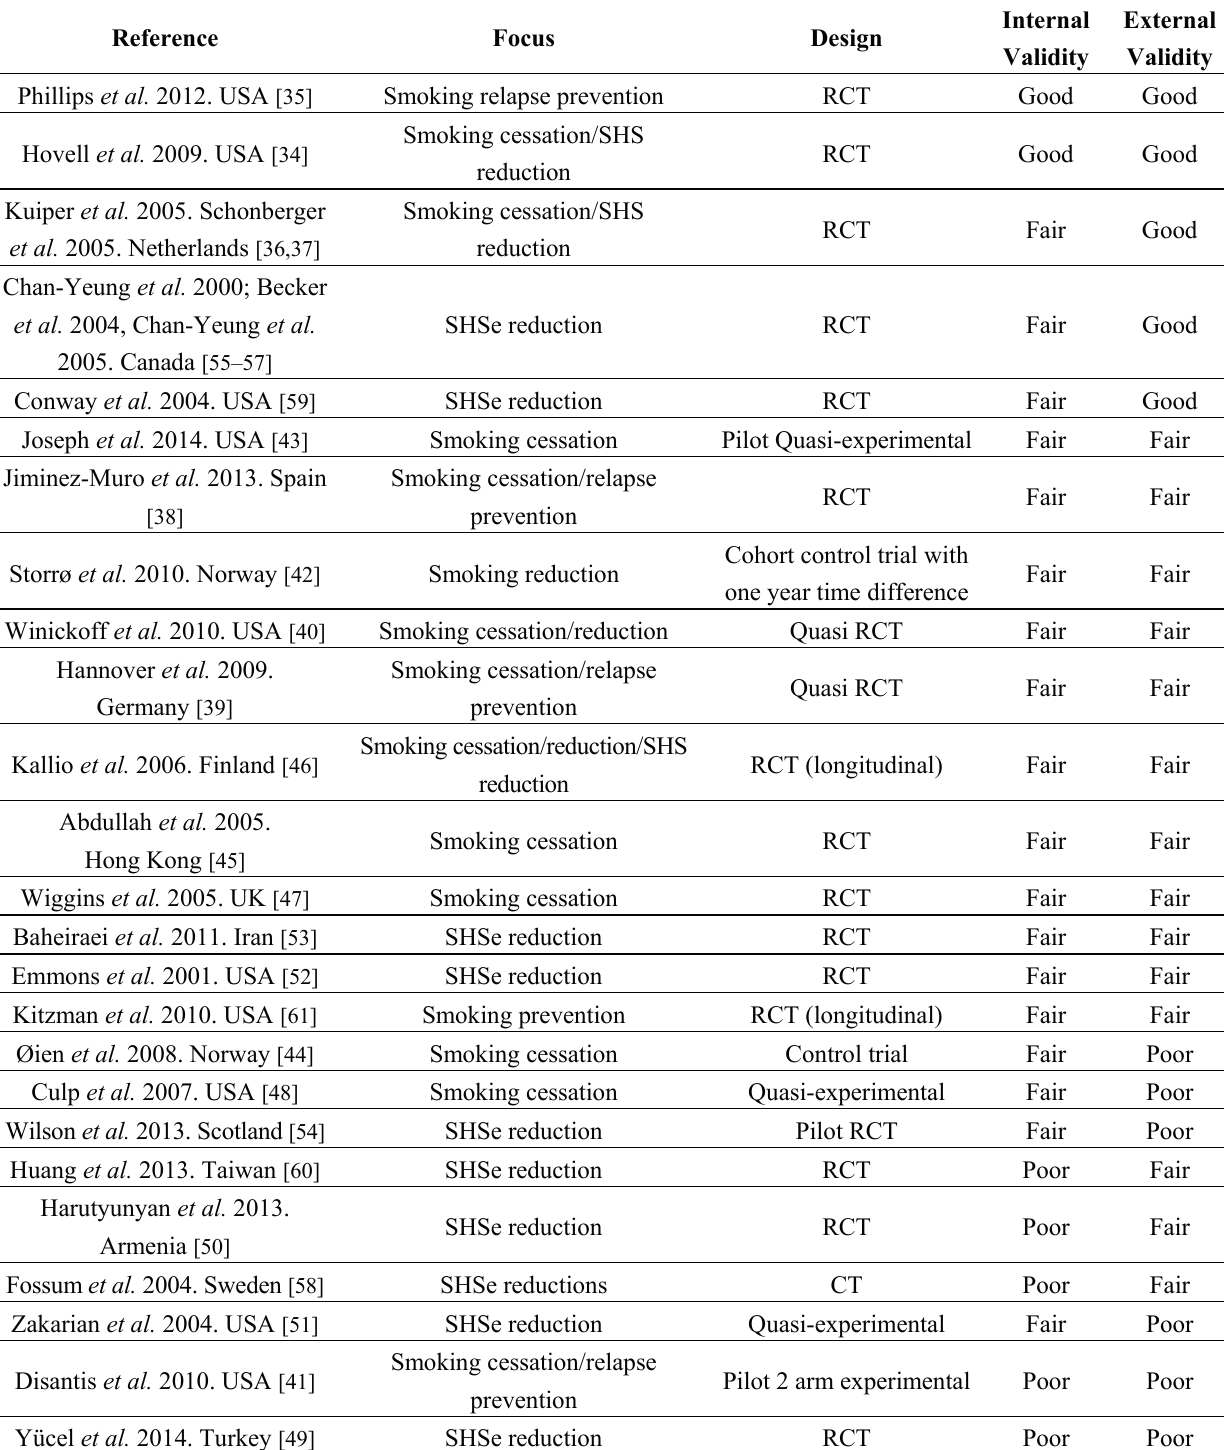
Table 2. Study design and level of quality (AHRQ